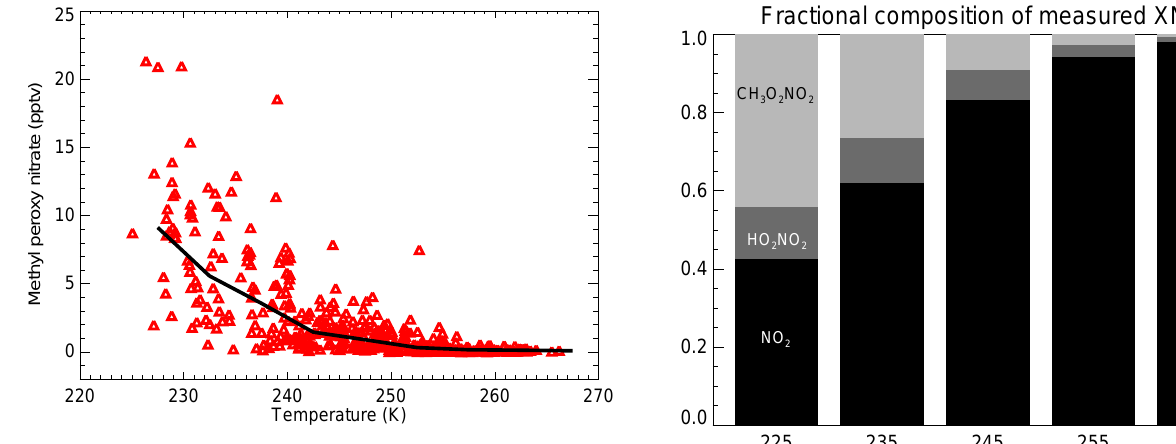
Fig. 1. Methyl peroxy nitrate concentration inferred from observa- tions. The black line represents temperature binned median values.